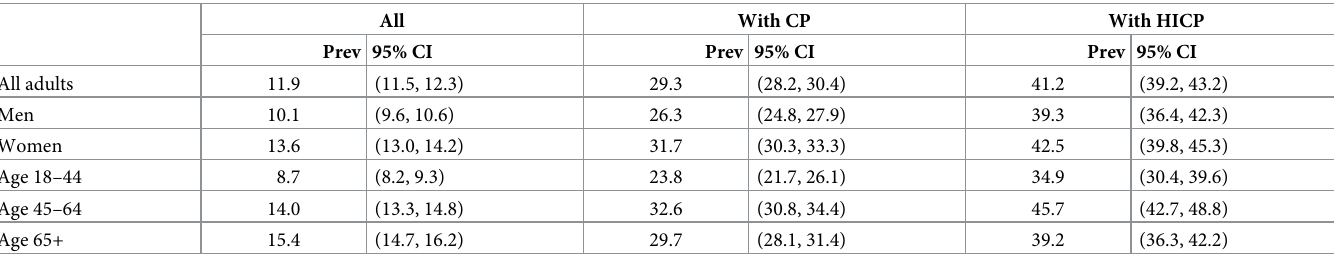
Table 1. Prevalence of prior-year prescription opioid use, US adults 2019–2020.